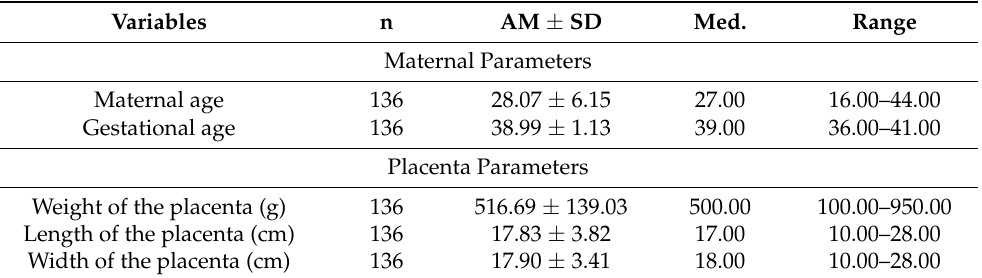
Table 1. General characteristics of the participants (AM, arithmetic mean; SD, standard deviation, Med., median; n, number of